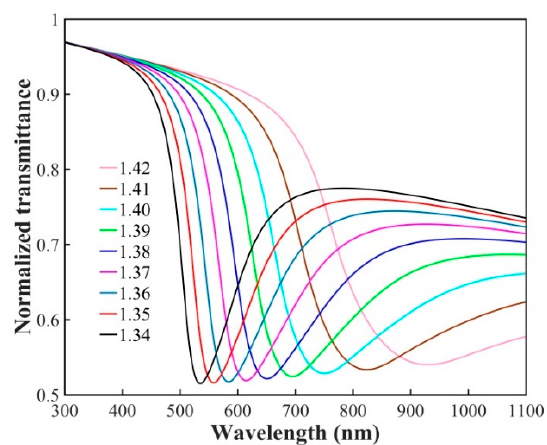
Figure 3. Simulation results of the double-sided polished SPR probe with an RI sensing range of